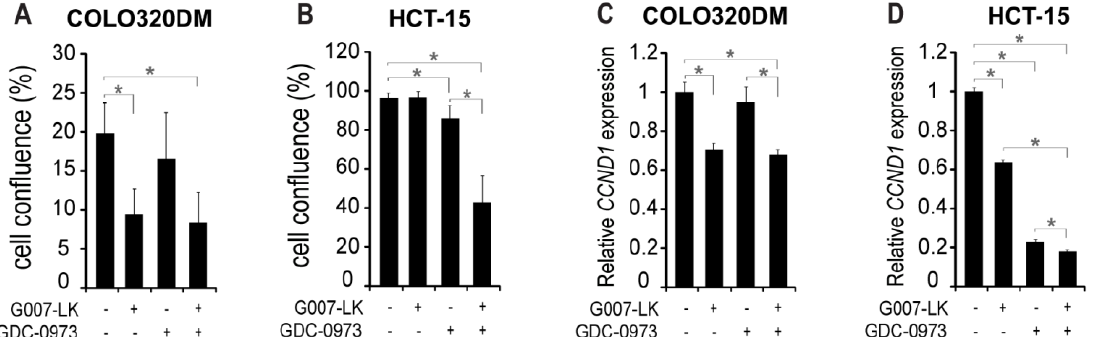
Figure 1. MEK inhibition potentiates HCT-15 cells for growth inhibition by the TNKS inhibitor. Cell confluence at experimental endpoint of the human colorectal cancer cell lines COLO320DM ( A ; 7 days incubation) and HCT-15 ( B ; 6 days incubation) in the presence of inhibitors as indicated. Relative expression levels of CCND1 were analyzed after 24 h incubation with inhibitors in COLO320DM ( C ) and HCT-15 ( D ) cells. Gene expression was normalized to internal GAPDH levels. Data represents mean relative expression values compared to the DMSO control ( ± STDEV) of 3 technical replicates. * p < 0.05.